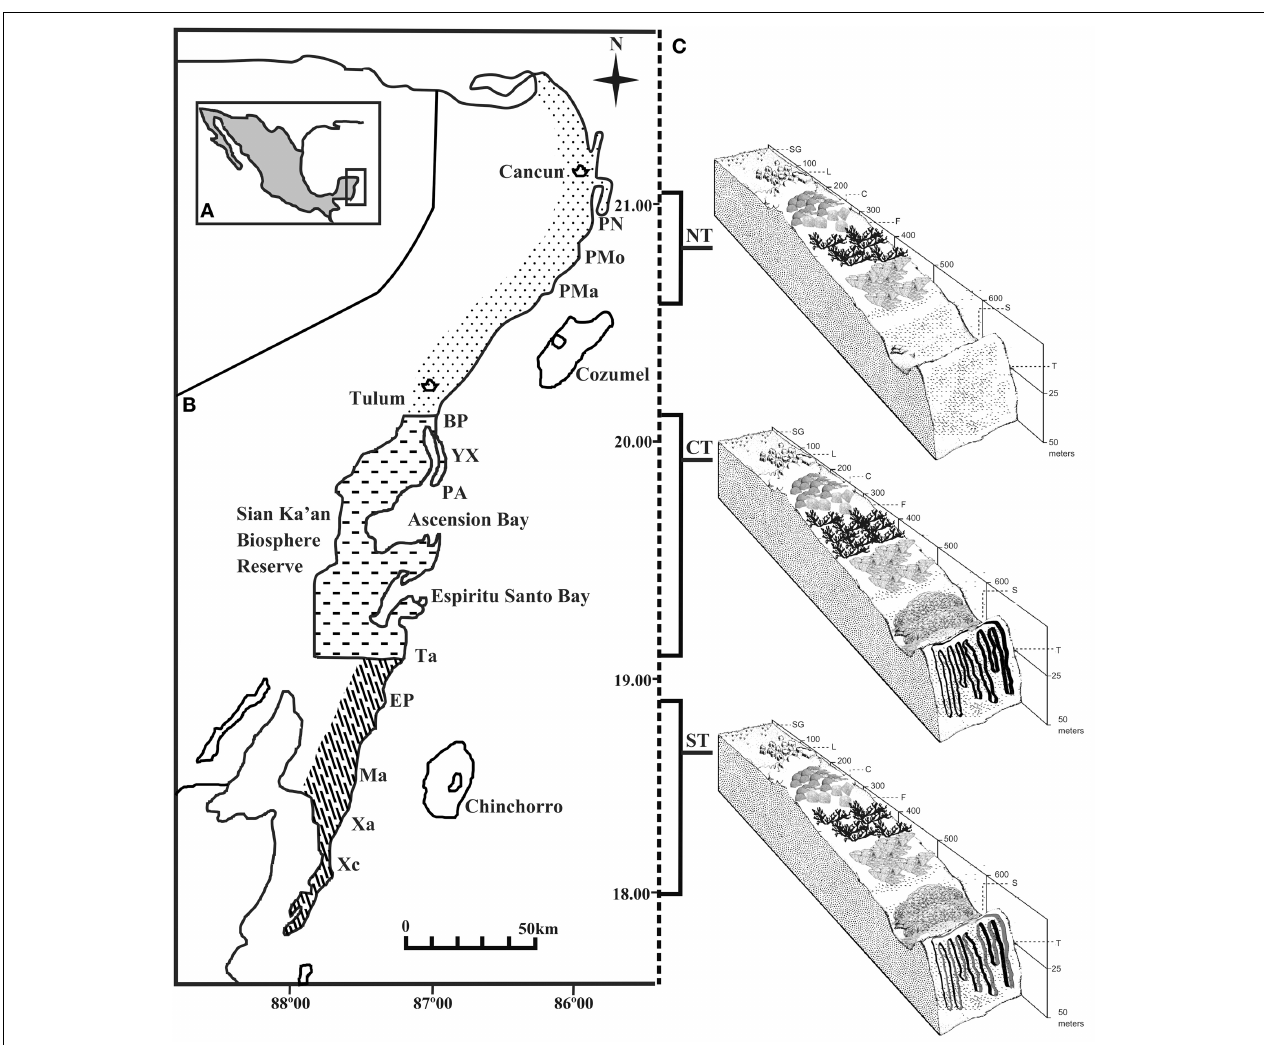
FIGURE 1 | Study area. (A) Yucatan Penisula. (B) Mexican Caribbean coast, with three regions. Eleven reef sites along the coast were selected for the study: Punta Nizuc (PN), Puerto Morelos (PMo), Punta Maroma (PMa), Boca Paila (BP), Yuyum (YX), Punta Allen (PA), Tampalam (Ta), El Placer (EP), Mahahual (Ma), Xahuayxol (Xa) and Xcalak (Xc). (C)